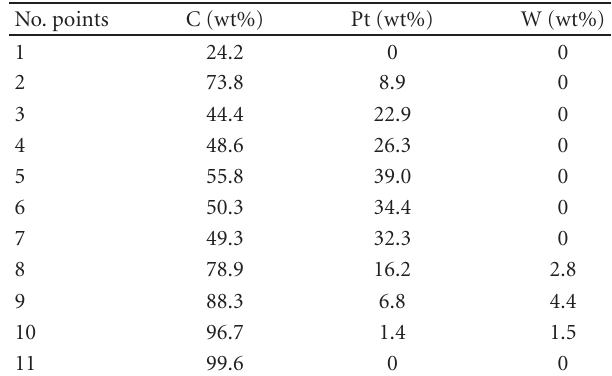
Figure 8: EDS spectra at the no. 5 point as indicated in Figure 6 (at the platinum nanowire).